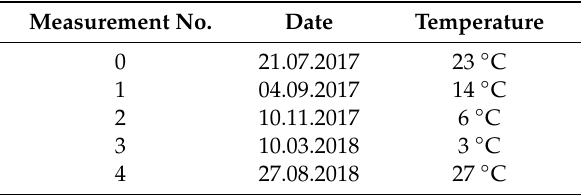
Table 1. Terms of geodetic measurements. Measurement